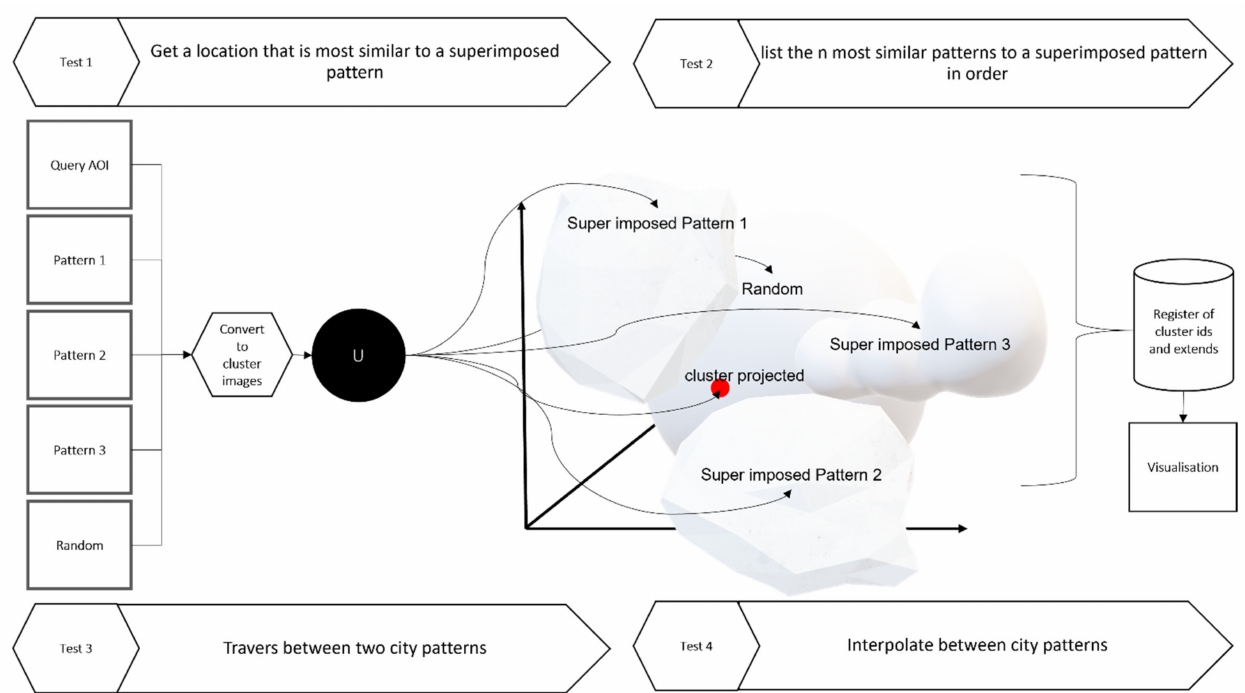
Figure 5. Mapping to a hidden manifold. The operation sequences demonstrate multiple operations that can be used to better understand and analyze the build-up patterns. U represents a function or mapping from a high to a low-dimensional